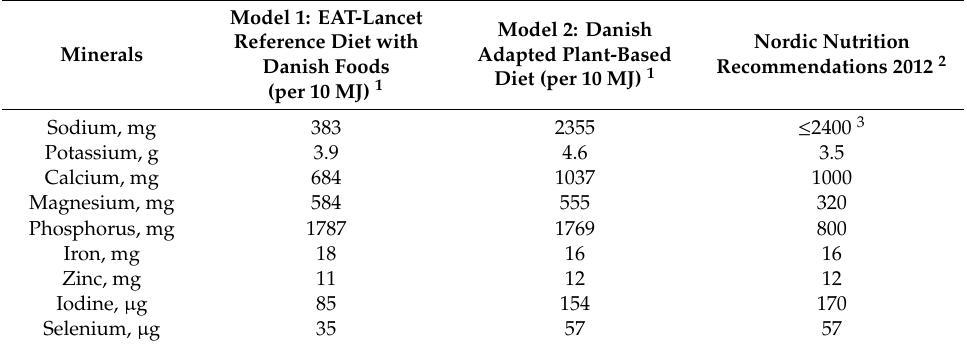
Table 4. Content of minerals in the EAT-Lancet reference diet with Danish foods (Model 1) and in the Danish adapted plant-based diet (Model 2) per 10 MJ, compared to the Nordic Nutrition Recommendations on nutrient